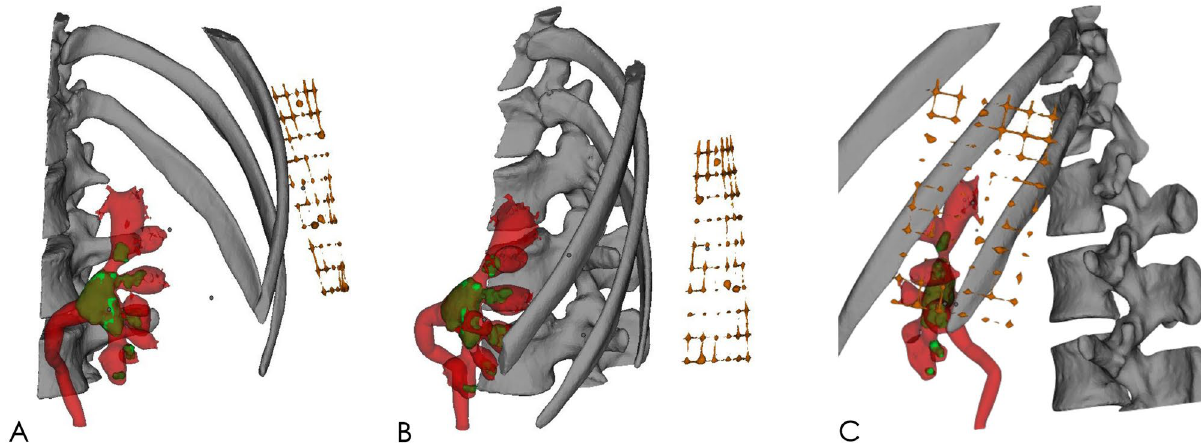
Figure 2. 3D visual model of the renal collecting system, renal calculi, and grid patch. ( A – C ), Front, side, and back views of the 3D visual model of the renal collecting system (red), kidney calculi (green), and grid patch (gold). The figure was created with Mimics 19.0 (https:// www. mater ialise.